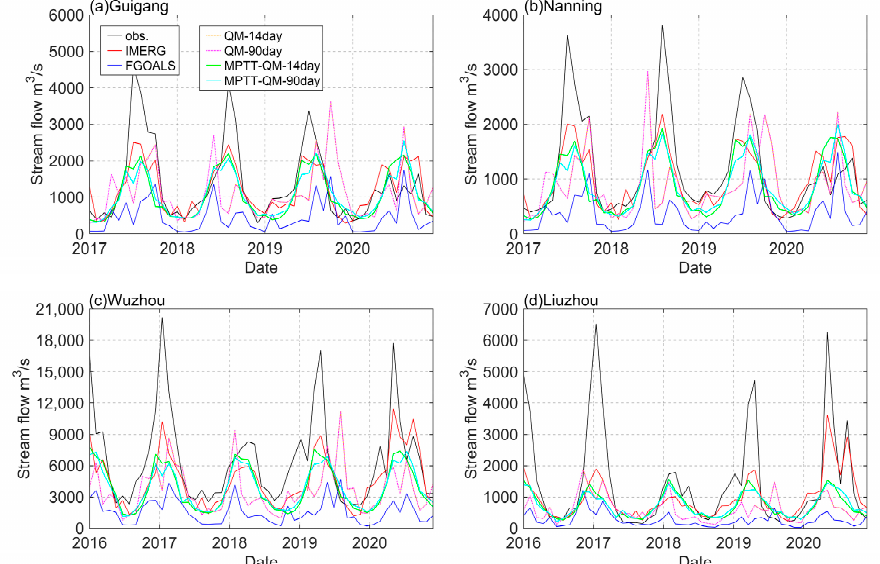
Figure 9. Runoff intensity–time curve of the PRB on the monthly scale from 2016 to 2020: ( a – d ) represent the Guigang, Nanning, Wuzhou, and Liuzhou stations, respectively.